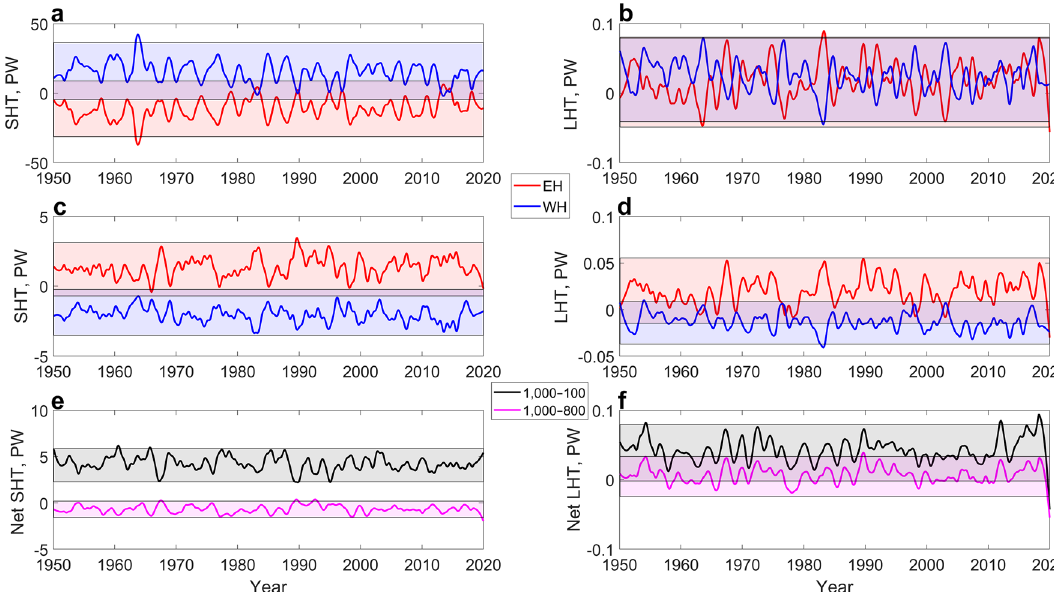
Figure 4. Smoothed time series of integral sensible and latent heat transport (SHT and LHT) components (Petawatt (PW)) in the lower and entire troposphere for the Eastern and Western Hemispheres (EH and WH) and the net fluxes. ( a ) 1000–100 hPa integral SHT in the EH and WH. ( b ) 1000–100 hPa integral LHT in the EH and WH. ( c ) 1000–800 hPa integral SHT in the EH and WH. ( d ) 1000–800 hPa integral LHT in the EH and WH. ( e ) Net fluxes of SHT (EH + WH). ( f ) Net fluxes of LHT (EH + WH). The lighter shaded areas indicate the interquartile ranges (differences between 75th and 25th percentiles) for the unsmoothed monthly time series, and the darker shaded areas show the intersections of the interquartile ranges for each pair of the time series. The loess smoothing was performed with a span of 5% of the values. The Matrix Laboratory (MATLAB) with version R2017b (https:// www. mathw orks. com/) was used to generate this figure.